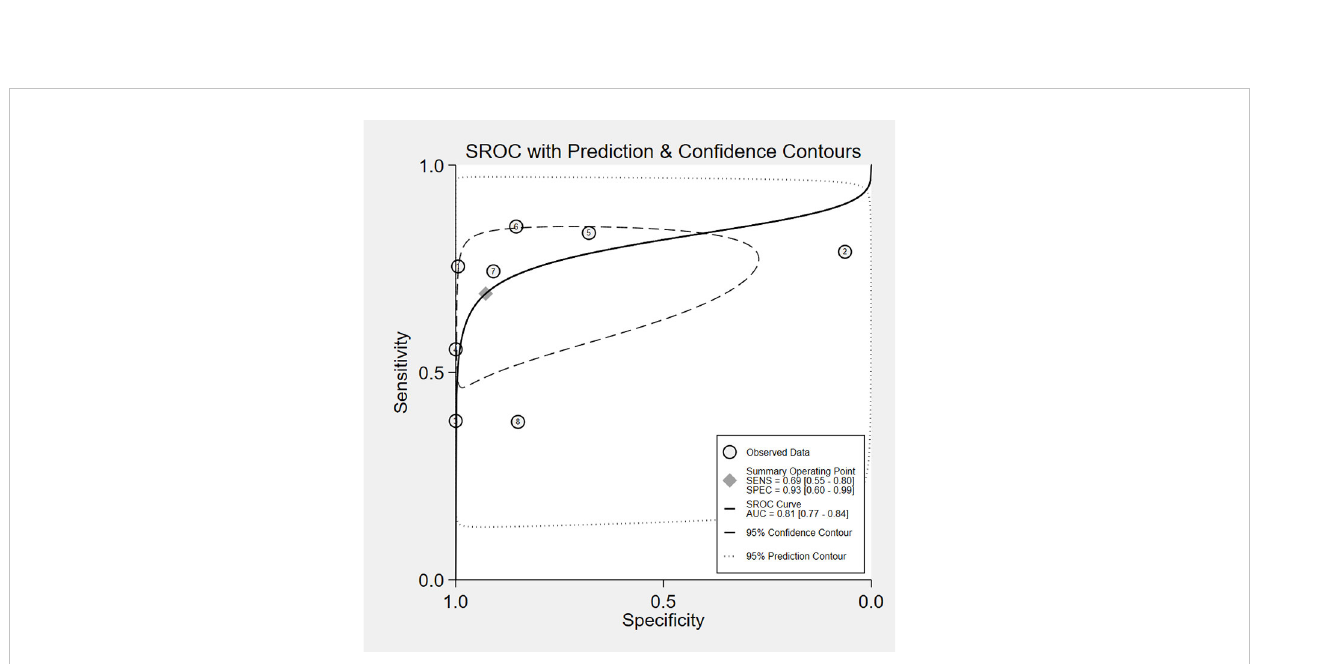
FIGURE 5 Deeks ’ funnel plot for detecting publication bias. ESS, effective sample